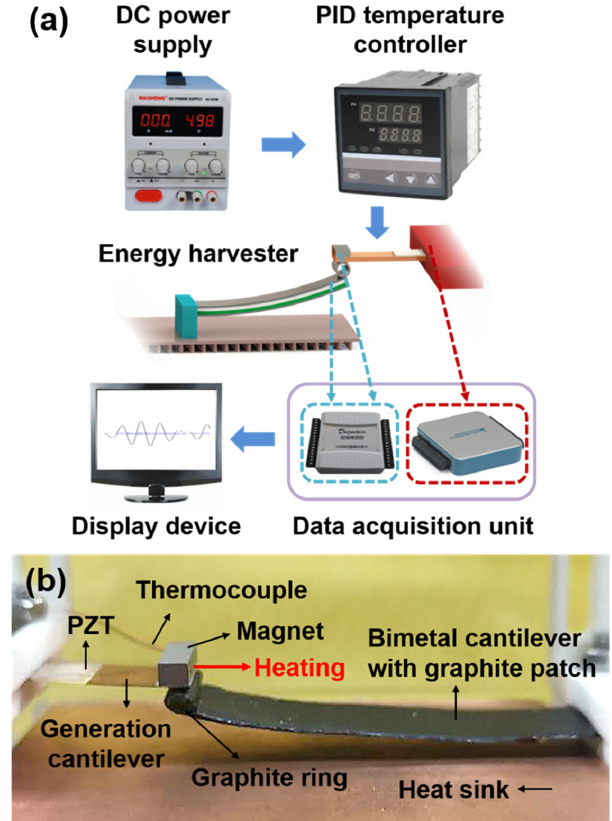
Figure 5. Experimental details of the heat event induced energy harvesting. ( a ) Schematic test setup of the energy harvester and ( b ) physical photo of the energy harvester prototype.